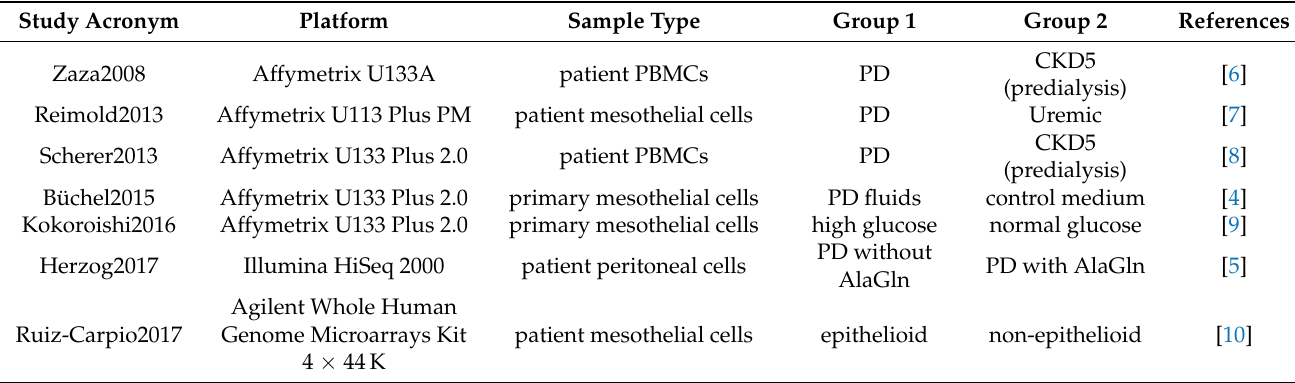
Table 1. Transcriptomics studies included in our meta-analysis. PD = peritoneal dialysis; CKD5 = chronic kidney disease stage 5; wt = wild type; HPG = hyperbranched polyglycerol; and AlaGln = alanyl-glutamine. Study